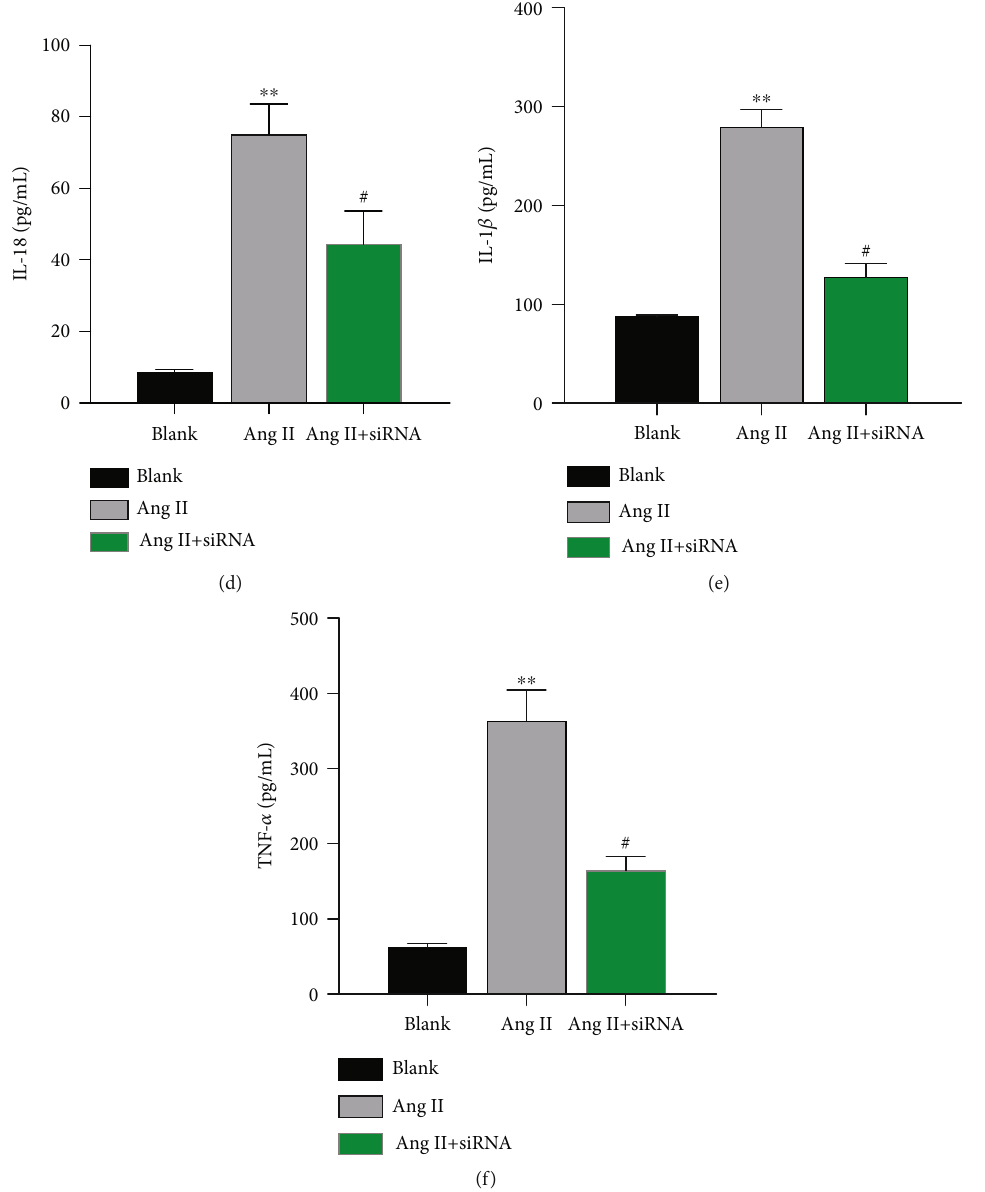
Figure 9: Knockdown of ASK1 attenuated ERS, ROS production, and in fl ammatory factors. (a) The production of fi broid- and ERS-related proteins was inhibited by ASK1 siRNA. (b) Immuno fl uorescence assays were performed to measure α -SMA expression in HSCs. (c) ROS production was inhibited by ASK1 siRNA. (d – f) The production of in fl ammatory factors IL-18 (d), IL-1 β (e), and TNF- α (f) was blocked by ASK1 siRNA. ∗ p < 0 : 05 and ∗∗ p < 0 : 01 vs. blank; # p < 0 : 05 vs. Ang